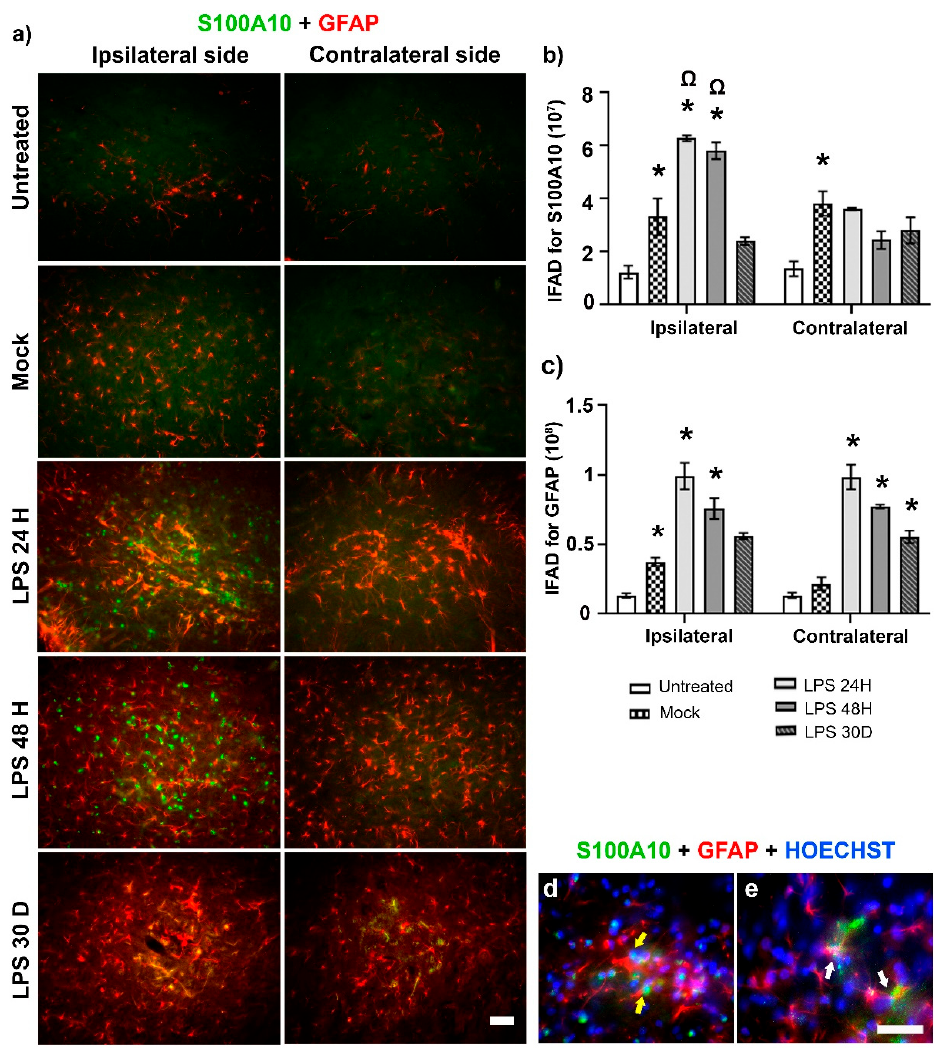
Figure 4. LPS induces the neurotrophic A2 phenotype in astrocytes of the SNpc. ( a ) Representative micrographs of the double immunofluorescence against S100A10 (green) and GFAP (red) at different times (shown at the left margin in each row) after LPS intranigral injection. The graphs show the IFAD for S100A10 ( b ) and GFAP ( c ) measured on the micrographs ( a ) using ImageJ software v.1.46r (National Institutes of Health; Bethesda, MD, USA). The bars represent the mean ± SEM calculated from the measurements in three anatomical levels per rat ( n = 3 independent rats per group). The asterisk (*) compares the LPS group with the Mock group on both sides. The omega symbol ( Ω ) compares the LPS effect on the ipsilateral SN with that on the contralateral side at 24 h and 48 h. Two-way ANOVA and post hoc Tukey tests, p < 0.05. Representative amplified micrographs show S100A10 immunoreactivity in ( d ) nuclei (yellow arrows) of GFAP (+) cells in the ipsilateral SNpc and ( e ) the cytoplasm of astrocytes (white arrows) in the contralateral side at 24 h post-lesion The scale bars = 50 µ m are for all